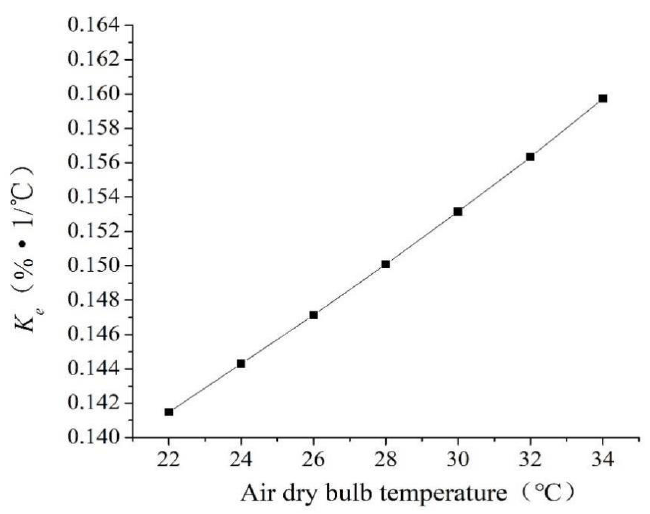
Figure 15. Relationship between K e and air-dry bulb temperature.